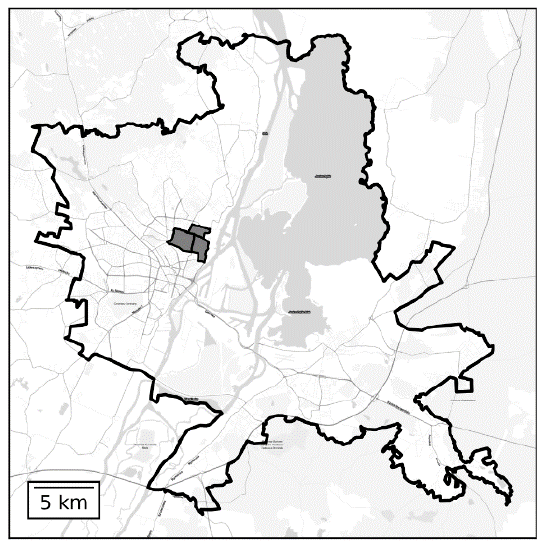
Figure 1. Location of the city of Szczecin within Poland.